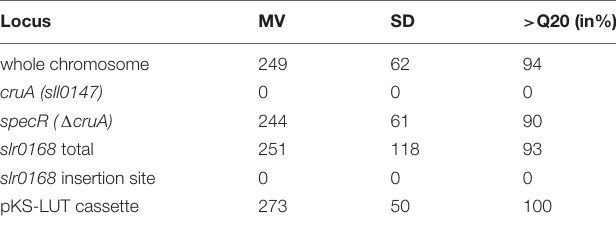
TABLE 1 | Analysis of genetically modified loci in synlut by whole-genome re-sequencing. Locus MV SD > Q20 (in%) whole chromosome 249 62 94 cruA